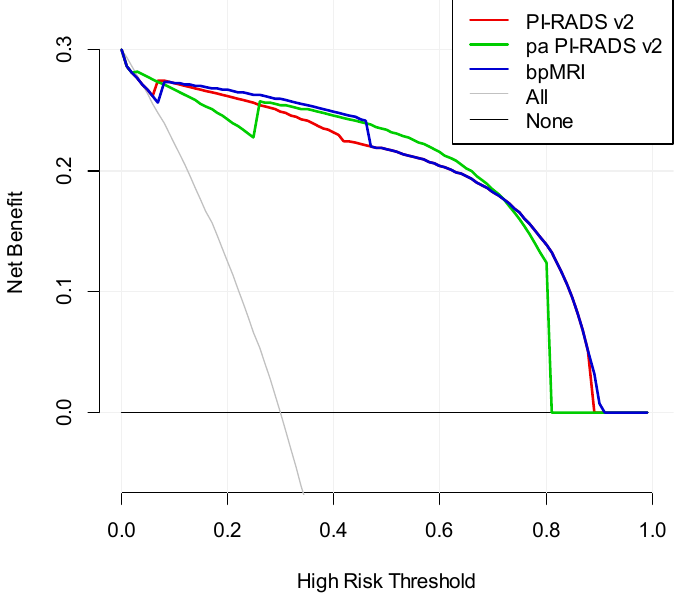
Figure 6. DCA for the diagnostic performance of the three protocols.